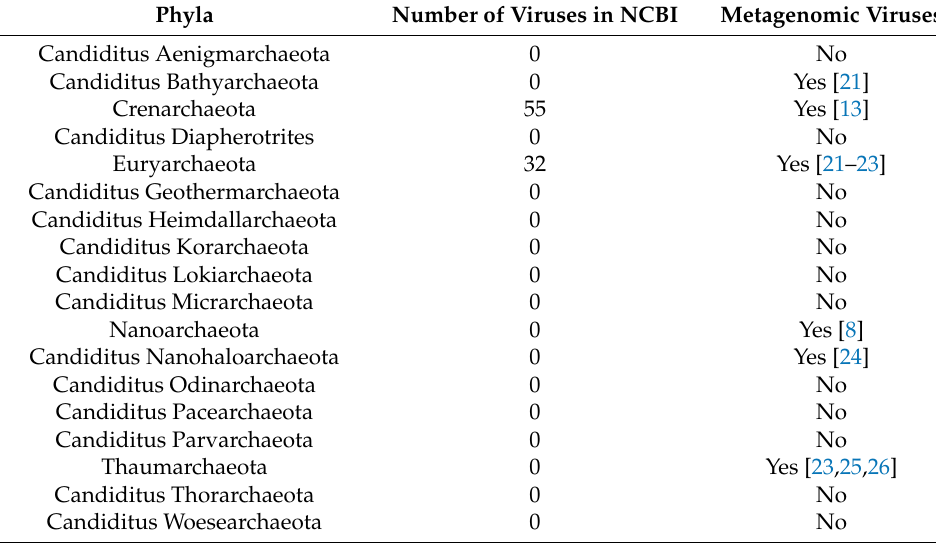
Table 1. Number of isolated viruses infecting archaeal phyla and candidate phyla with metagenomic evidence of viruses. Archaeal phyla and candidate phyla were curated from the National Center for Biotechnology Information (NCBI) taxonomy browser [20] on 9 February 2018. The number of